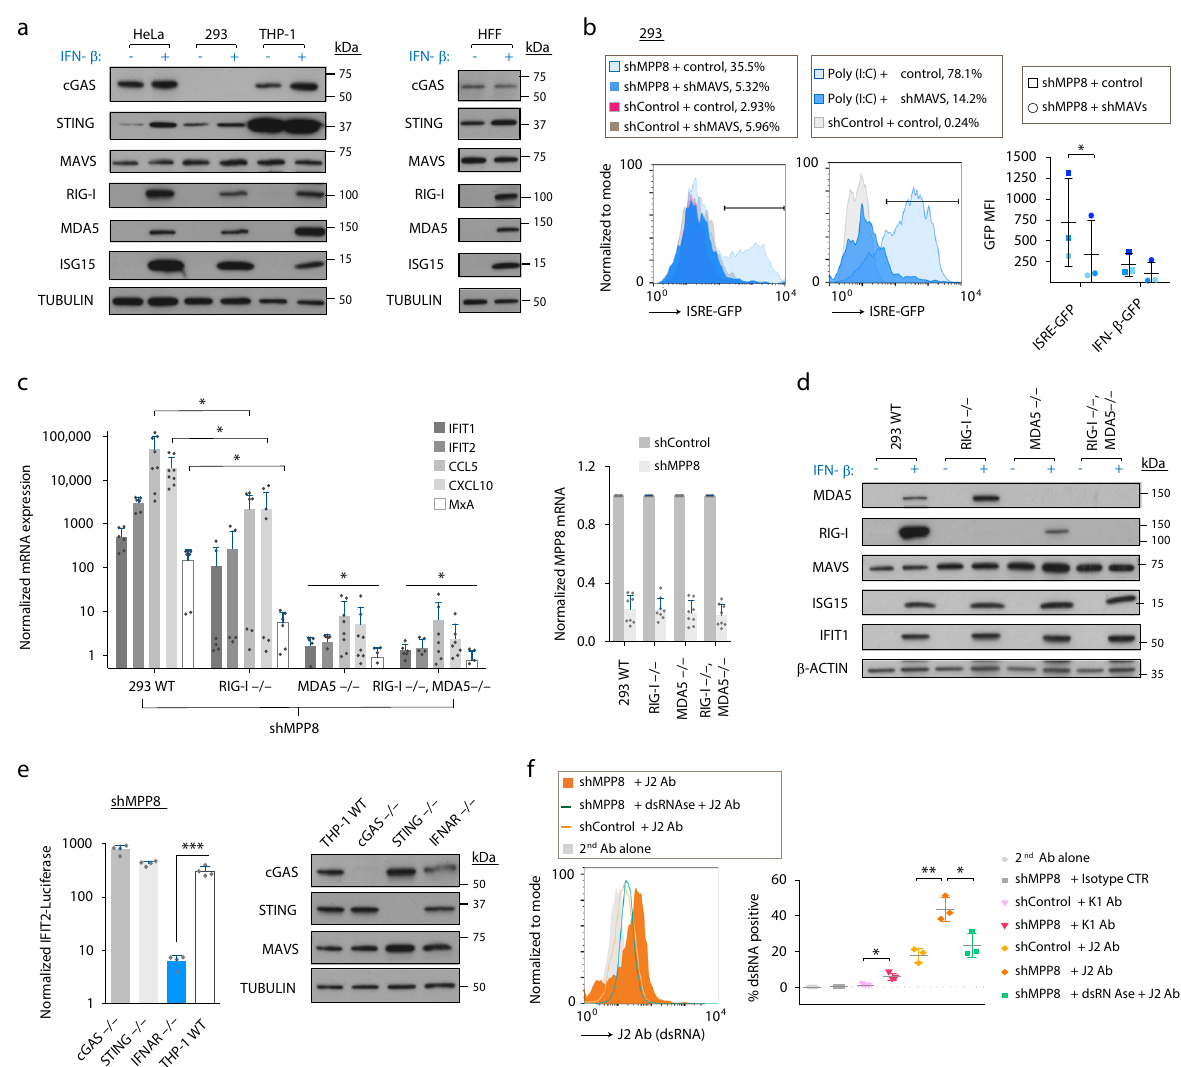
Fig. 3 MPP8-depletion is accompanied by RLR-dependent RNA sensing. a Western blots on extracts from stated cells treated ± IFN- β for 24 h. N = 2 independent blots with one representative blot shown. b 293 cells were co-transduced with shControl or shMPP8 plus shMAVS or a control vector of the same backbone ( hygromycin ) and GFP was measured on day 6 (left). MAVS depletion was veri fi ed using polyI:C, added 24 h before FACS (middle). Summary data shown for experiments in ISRE-GFP and IFN- β -GFP reporter cells (right, n = 3 biologically independent samples). P = 0.0372 (one-tailed paired t test). MFI: mean fl uorescent intensity. c Left: qRT-PCR expression of endogenous ISGs in the stated shRNA-treated 293 cell lines at day 6 ( GAPDH normalized ) . N = 4 biological independent experiments with technical duplicates shown. CCL5 and CXCL10 were measured in all experiments while the other 3 ISGs were measured in 3 of the experiments. One-tailed paired t tests showed expression of all ISGs was signi fi cantly lower in MDA5 − / − cells and double knockout (DKO) cells than in wildtype (WT) controls. IFIT1: p = 0.0063 (MDA5 − / − ), p = 0.0026 (DKO); IFIT2: 0.0007 (MDA5 − / − ), 0.0019 (DKO); CCL5: 0.0002 (MDA5 − / − ), 0.0028 (DKO); CXCL10: 0.0001 (MDA5 − / − ), 0.0007 (DKO); MxA: 0.0427 (MDA5 − / − ), 0.0423 (DKO). Expression of CCL5, CXCL10, and MxA was signi fi cantly decreased in RIG-I − / − cells compared to controls. CCL5: p = 0.0183; CXCL10: p = 0.0372; MxA: p = 0.0139. Right: MPP8 depletion ef fi ciency summary ( n = 4 biologically independent experiments with technical duplicates shown. d Western blots on extracts from cell lines from c treated ± IFN- β for 24 h. N = 2 independent blots with one representative blot shown. e Left: stated knockout or control (WT) THP-1 reporter cell lines were treated with shRNAs and assayed for secreted Lucia luciferase (driven by IFIT-2) 6 days later. N = 4 biologically independent experiments. Luciferase readings were normalized to background values in shControl -treated cells. P = 0.0003 (one-tailed paired t test). Right: western blots on extracts from stated cells. N = 3 independent blots with one representative blot shown. f 293 cells were treated with shRNAs and fi xed 6 days later for intracellular staining with dsRNA antibodies, J2/K1 or control antibodies. N = 3 biologically independent samples. Two-tailed unpaired t test p values = 0.0166 (shMPP8 vs. shControl for K1 Ab); 0.0048 (shMPP8 vs. shControl for J2 Ab); 0.0212 (shMPP8 + J2 Ab ± dsRNase). All data presented in this fi gure show mean values ±